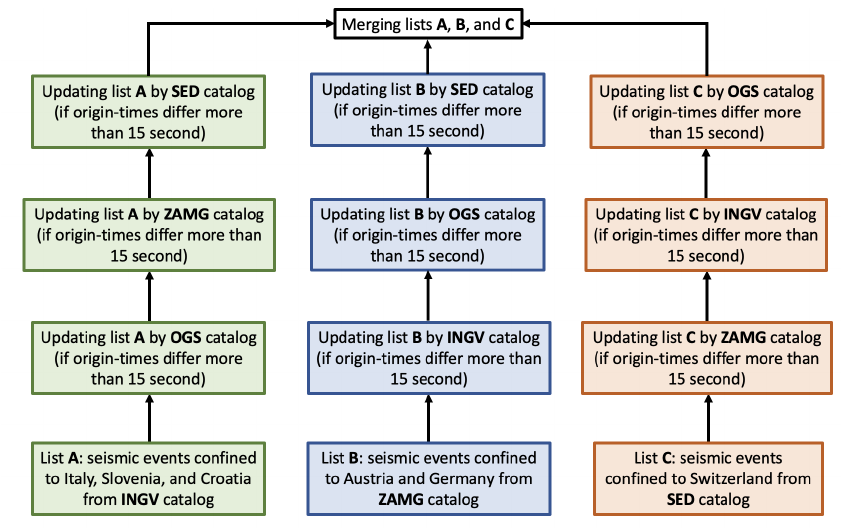
Figure A1. Flow chart showing the process of merging seismic catalogs of INGV, OGS, ZAMG, and SED in order to derive an integrated seismic event list in the study